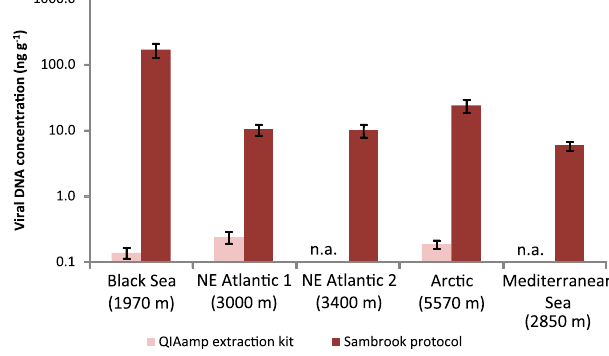
Figure 1. Comparison of viral DNA concentrations obtained using the QIAamp DNA extraction kit and the Sambrook protocol. Mean (n = 3) and standard deviations are shown. n.a. = not available.